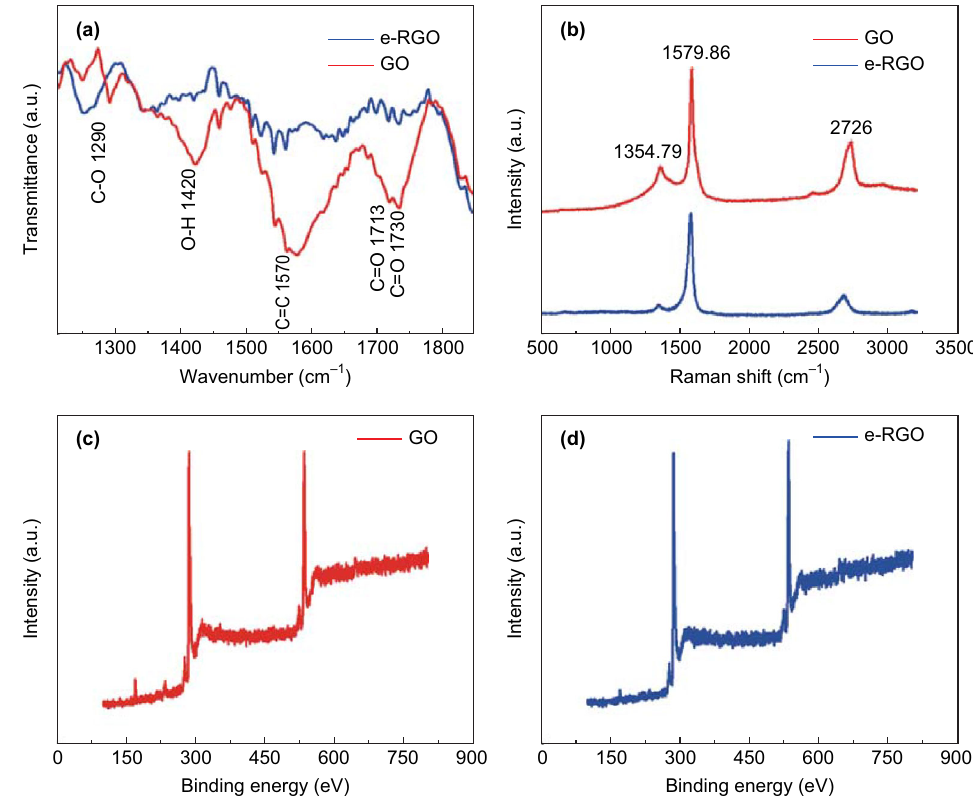
Fig. 4 a Functionalization study of GO and e-RGO using FTIR analysis. b Raman spectra of GO and e-RGO. c XPS analysis of GO and e-RGO